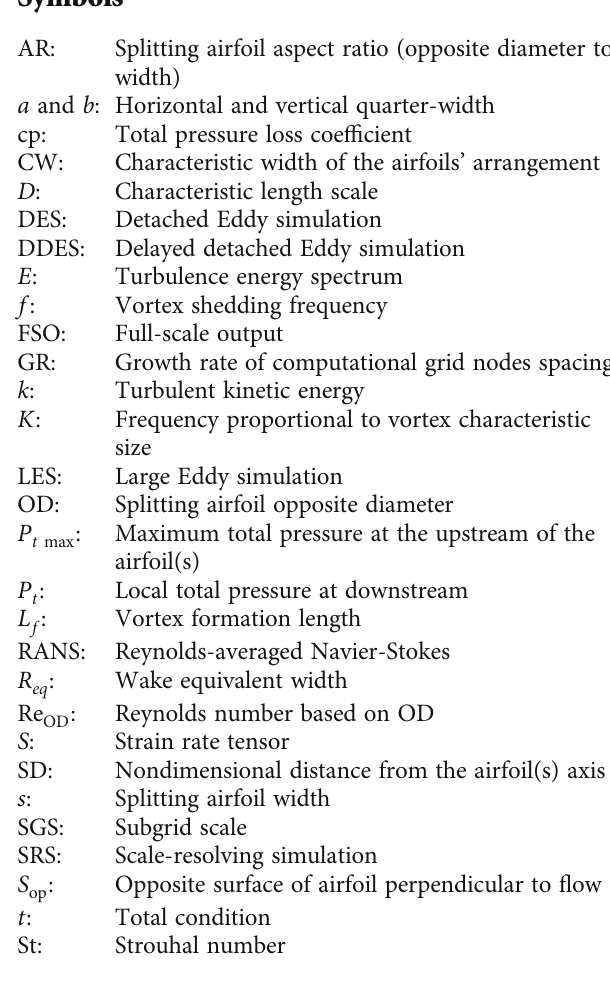
Figure 18: Illustration of CW e ff ects on R arrangements of 90new3 with 30 °